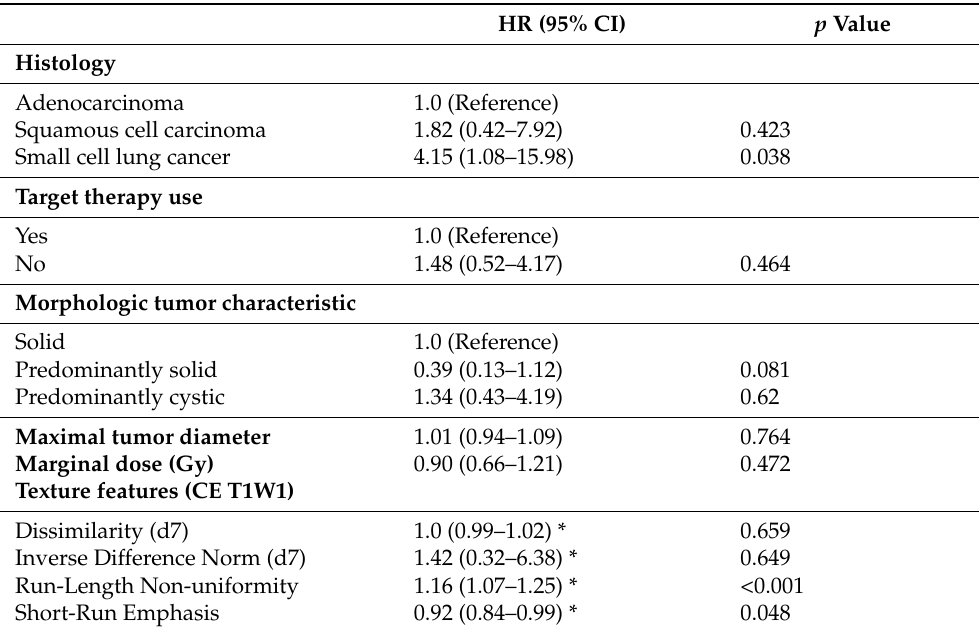
Table 3. Multivariable Cox proportional hazards regression analysis of factors affecting local progression-free survival in all patients. HR (95%